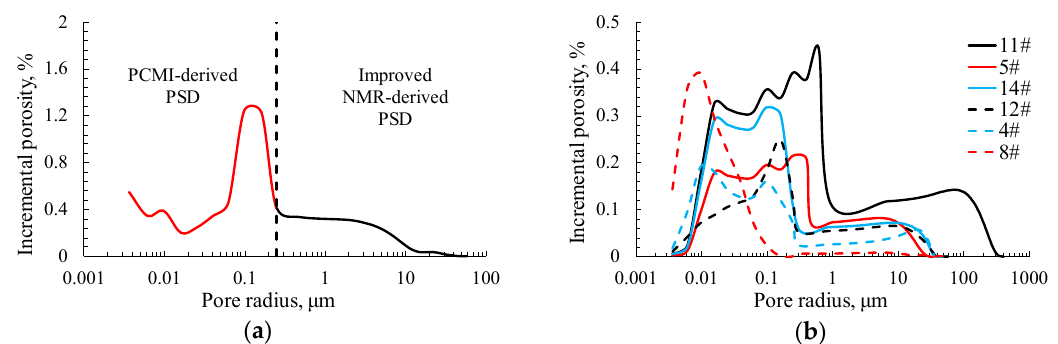
Figure 12. Full-range PSD by the integration of improved-NMR PSD and PCMI: ( a ) sample B116; ( b ) the PSDs of all specimens measured in this research.